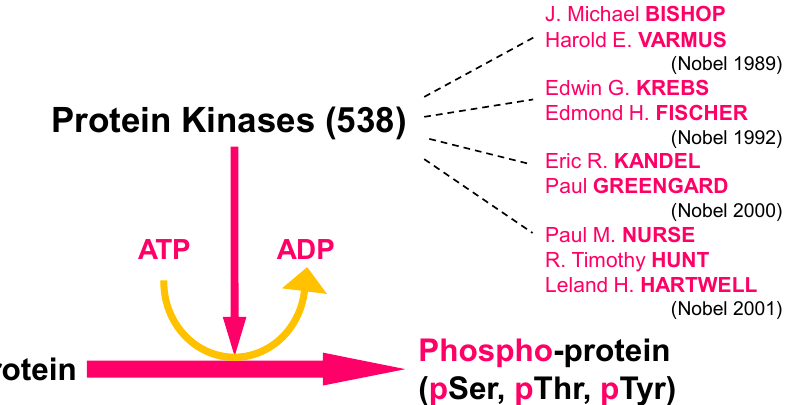
Figure 1. Four Nobel Prizes in Physiology or Medicine awarded in the field of protein phospho- rylation and protein kinases. Protein kinases catalyze the transfer of the γ -phosphate of ATP to the hydroxyl substituents of serine, threonine, or tyrosine residues in proteins, thereby altering the physiological properties of their protein substrates. The human kinome comprises 538 protein kinases. Michael Bishop and Harold E. Varmus received the Nobel Prize 1989 “for their discovery of the cellular origin of retroviral oncogenes” (src, the first described oncogene, which encodes a tyrosine kinase). Edmond H. Fischer and Edwin G. Krebs received the Nobel Prize 1992 “for their discoveries concerning reversible protein phosphorylation as a biological regulatory mechanism” (they are the true discoverers of protein kinases). The Nobel Prize 2000 was awarded jointly to Arvid Carlsson, Paul Greengard, and Eric R. Kandel “for their discoveries concerning signal transduction in the nervous system” (Paul Greengard investigated the mechanism of signal transduction of neurotransmitters in the central nervous system and demonstrated the key importance of phosphorylation by kinases such as CDK5, PKA, CK1, and CK2 and Eric Kandel the importance of PKA in memory in Aplysia ). The Nobel Prize 2001 was awarded jointly to Leland H. Hartwell, Tim Hunt, and Paul M. Nurse “for their discoveries of key regulators of the cell cycle” (using yeast or sea urchin embryos, they discovered how the cell division cycle is regulated by CDKs). For more information on each of these awardees, see: https://www.nobelprize.org/prizes/medicine/ (accessed on 1 June 2021).